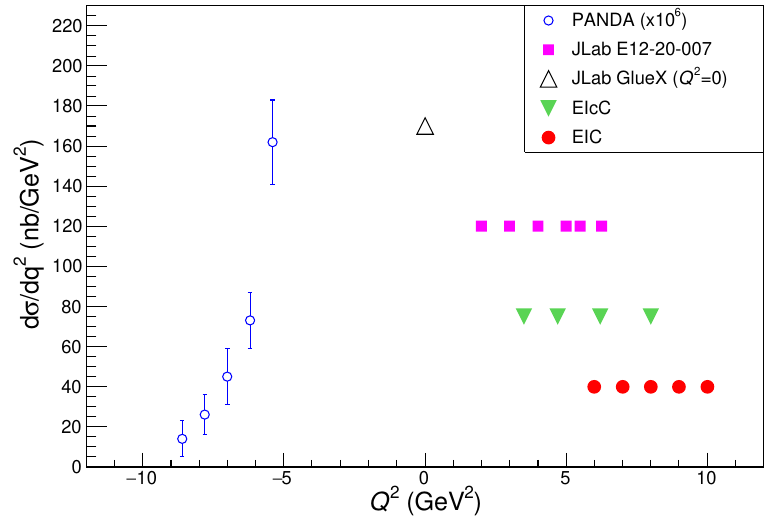
Figure 3: The anticipated global data set of d σ/ dq 2 ( γ ∗ p → p π 0 ) vs Q 2 at fixed s = 10 GeV 2 . Projected results from PANDA (FAIR) q 2 = − Q 2 scaling are in open blue circle; projected JLab E12-20-007 measurements are in magenta square; projected EIC measurements are in red full circle; JLab GlueX photoproduction measurement ( Q 2 = 0 GeV 2 ) is indicated by the open triangle. These experimental programs are elaborated in the relevant